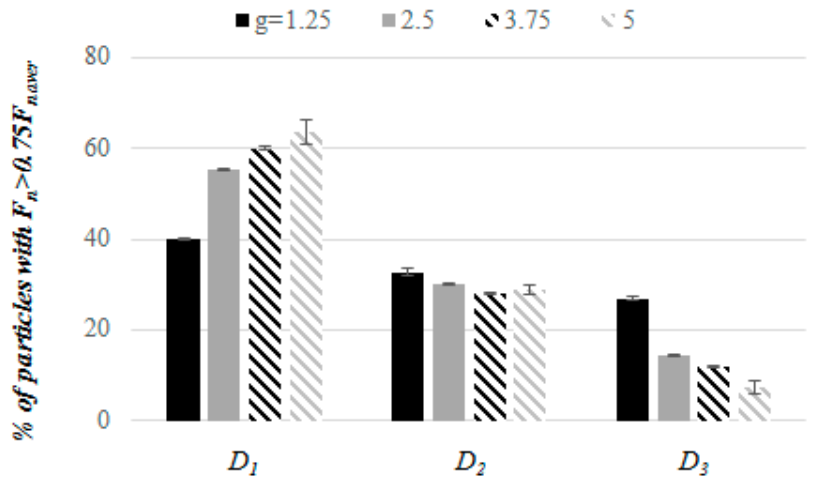
Figure 8. Average normal contact forces ( a ) and probability density functions of normal contact forces ( b ) in compressed mixtures with PSD uniform by number of spheres and various values of g.